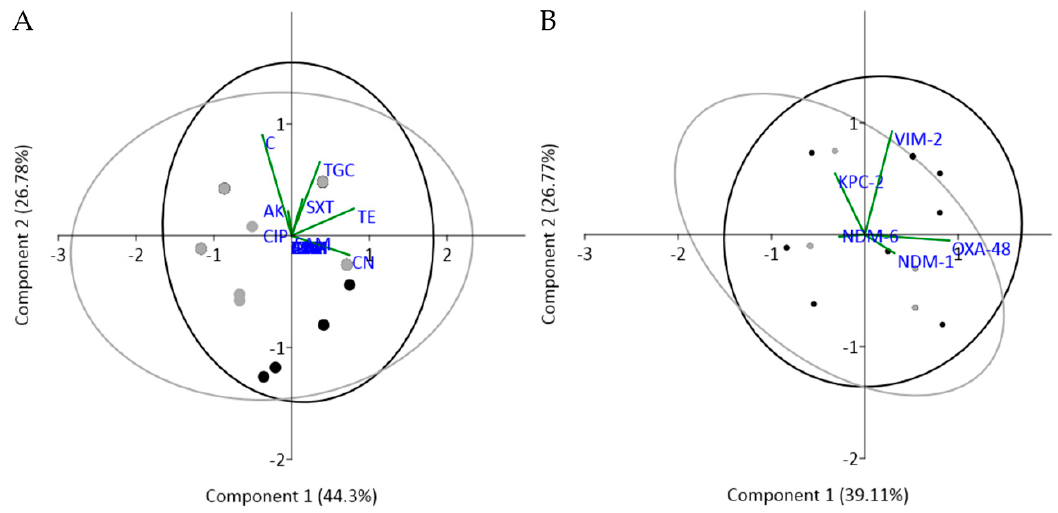
Figure 4. Principal component analysis (PCA) clustering of K. pneumoniae isolates according to the susceptibility to 16 antibiotics ( A ) and to the abundance of seven CRGs ( B ). Black dots—S1; gray dots—S2. ATM = aztreonam; AK = amikacin; CN = gentamycin; TE = tetracycline; TGC = tigecycline; C = chloramphenicol; SXT = trimethoprim-sulfamethoxazole.